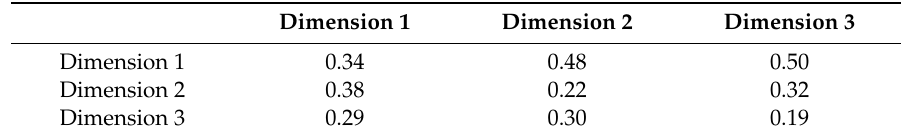
Table 5. Unweighted supermatrix for the dimensions.